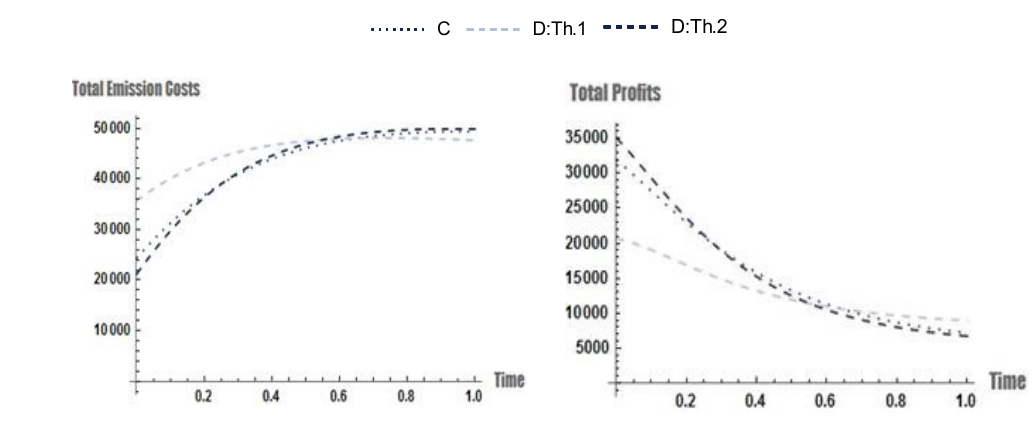
Figure 2. Total production quantities and total inventory.